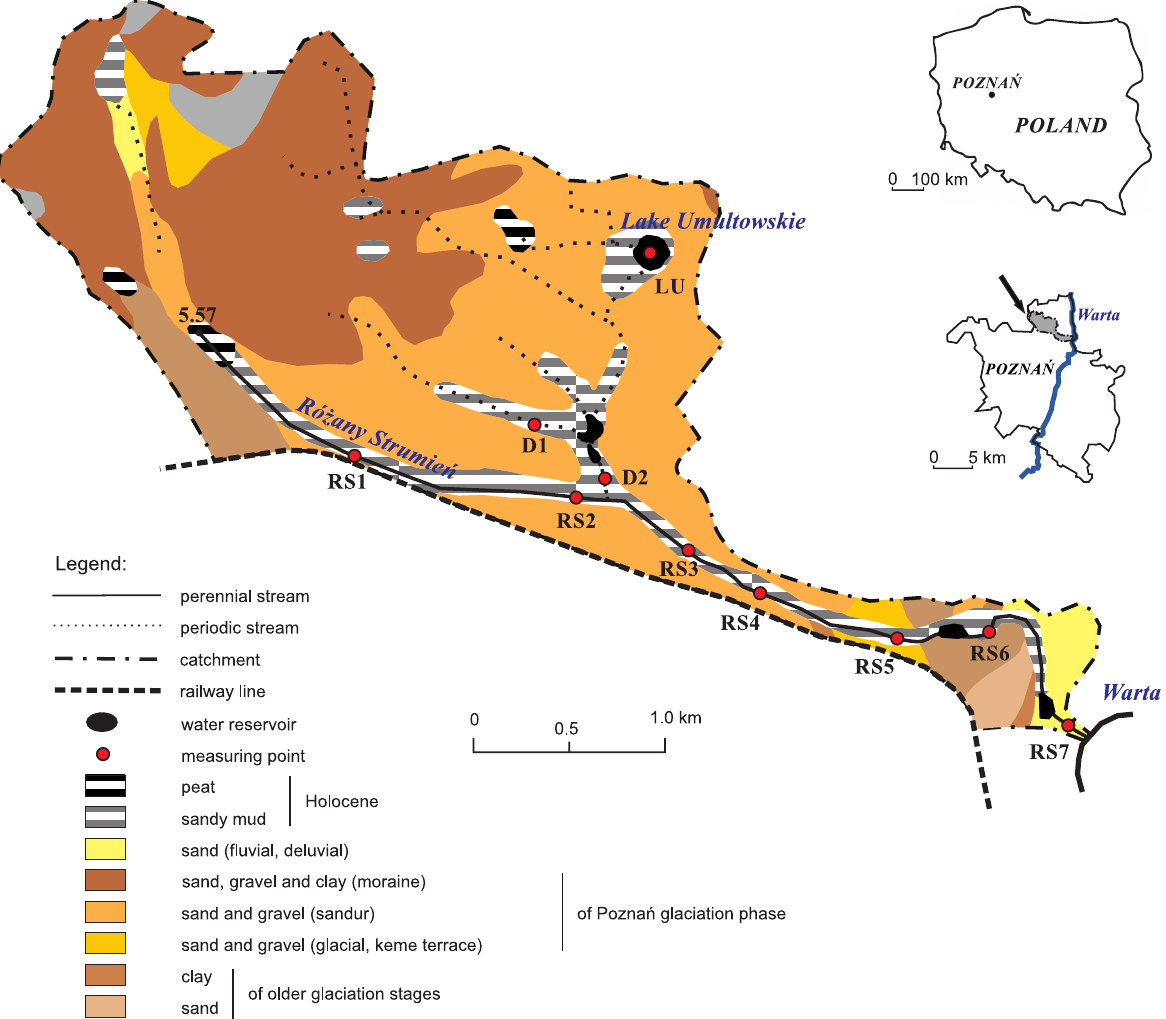
Fig. 1. The Różany Strumień catchment (hydrography based on the Atlas... 2005 and hydrographic plotting, geology following Szczegółowa Mapa...